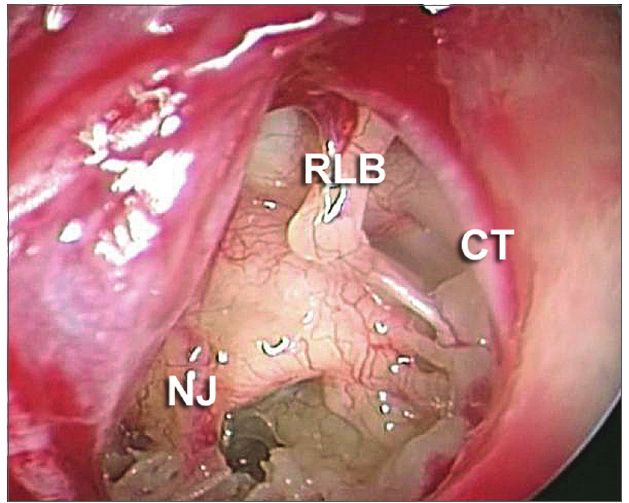
Figura 2. Imagem endoscópica, com instrumento de 0 graus, após a confecção do retalho tímpano-meatal. Visualizam-se importantes estruturas da orelha média, tais como ramo longo da bigorna (RLB), nervo corda do tímpano (CT) e, em alguns casos, até mesmo o nervo de Jacobson